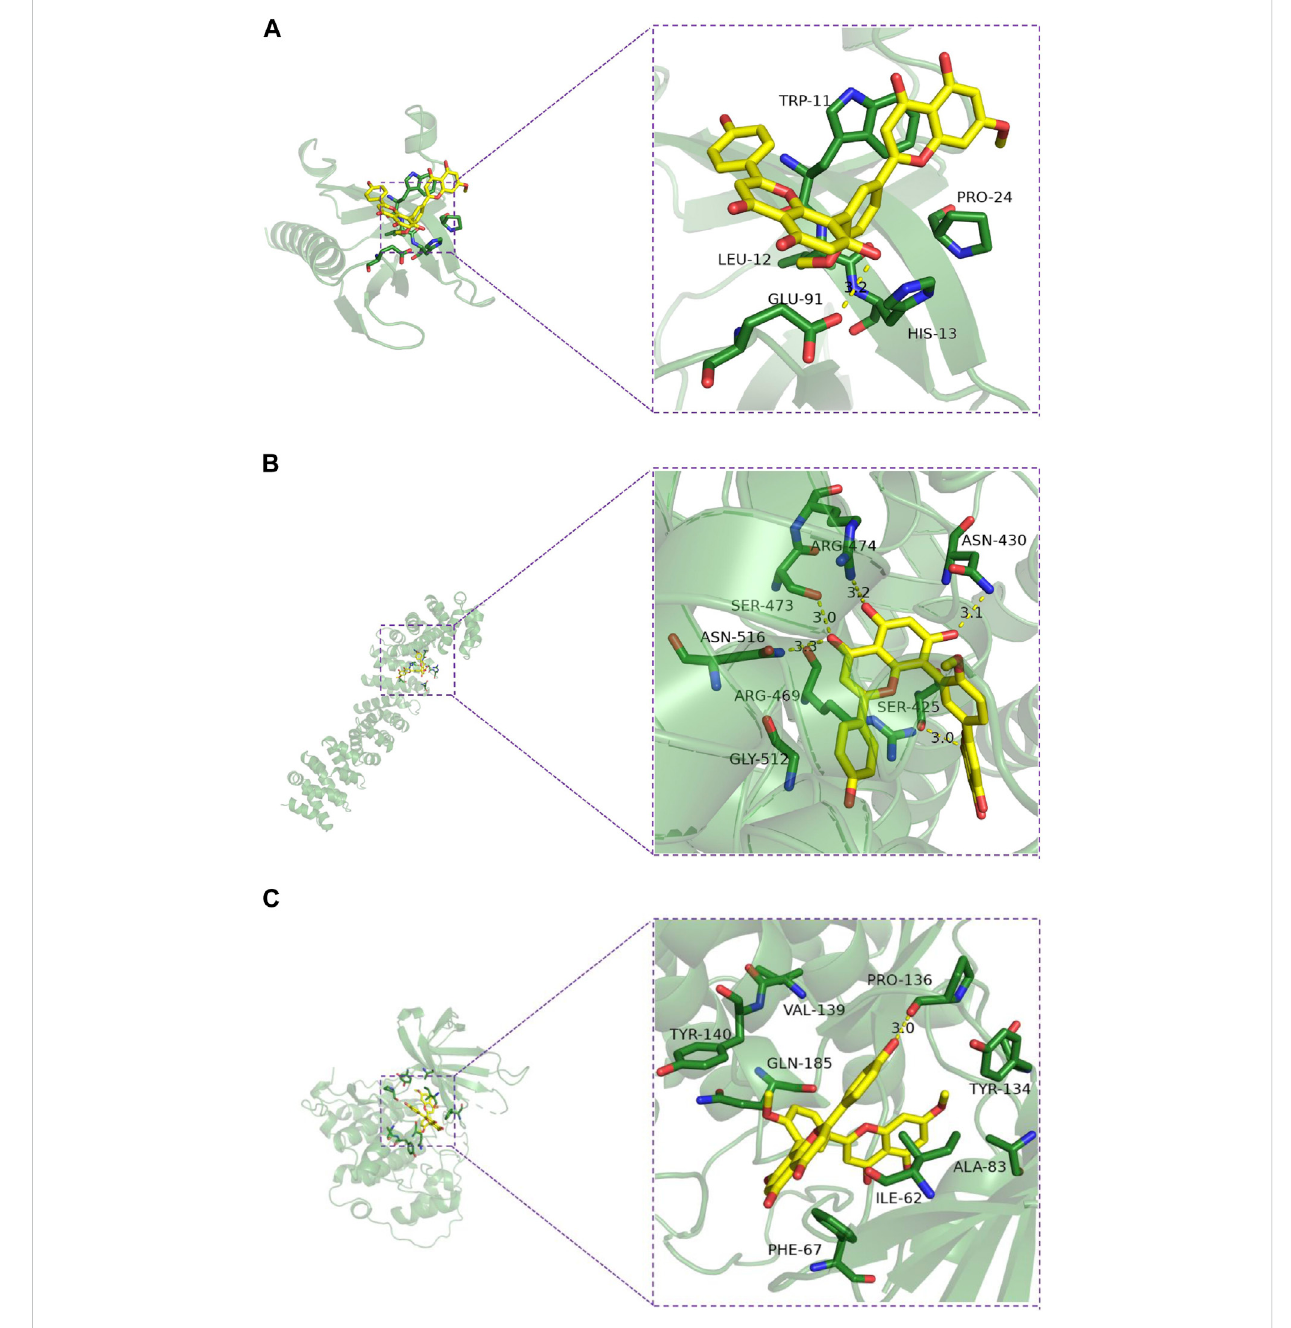
FIGURE 7 Molecular docking model diagram of the key substances-core targets. (A) Ginkgetin-Akt1; (B) Ginkgetin- β -catenin; (C) Ginkgetin-GSK-3 β .